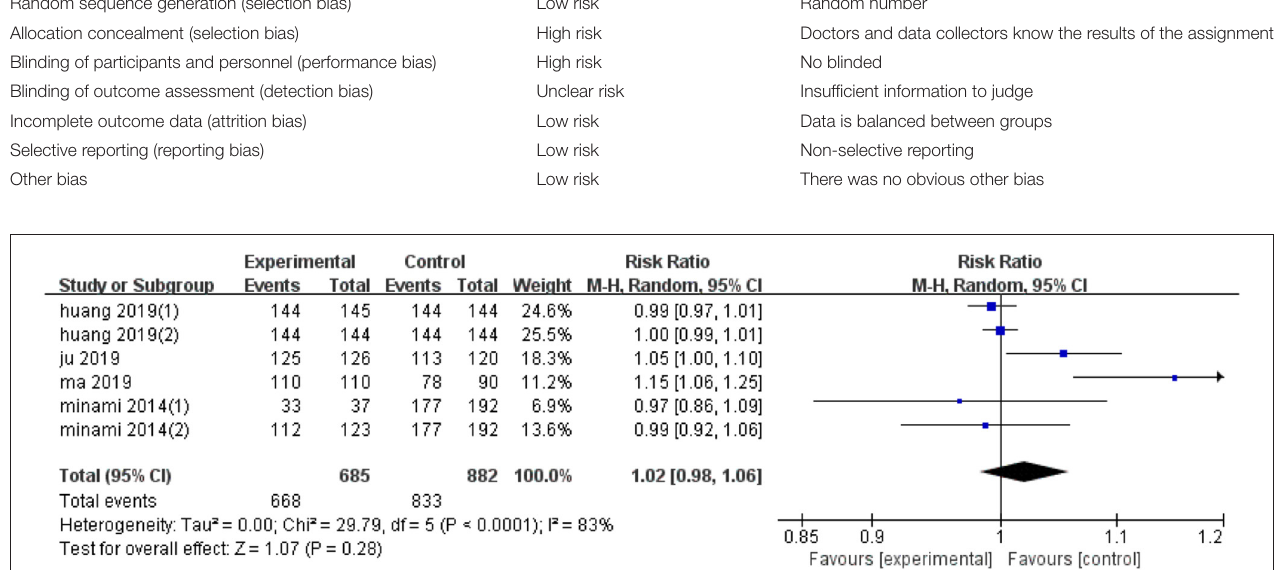
FIGURE 2 | Forest plot of the effects of ultrasonic image fusion on technical